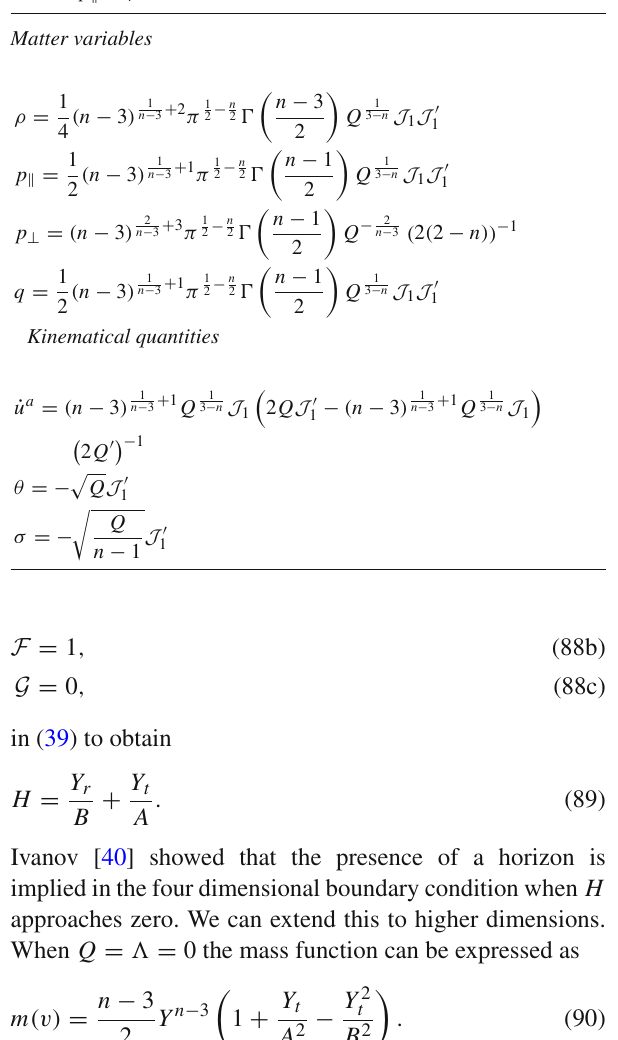
Table 2 Physical features for the boundary condition with an equation of state p (cid:3) = ρ Matter